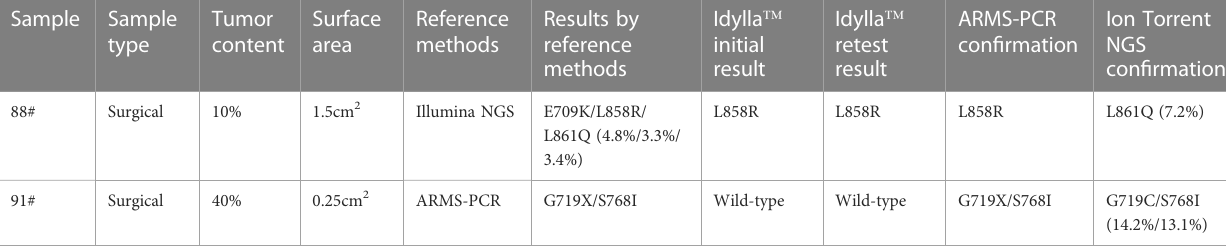
TABLE 1 Discordant cases between the Idylla ™ EGFR assay and reference methods in the 95 retrospective samples.